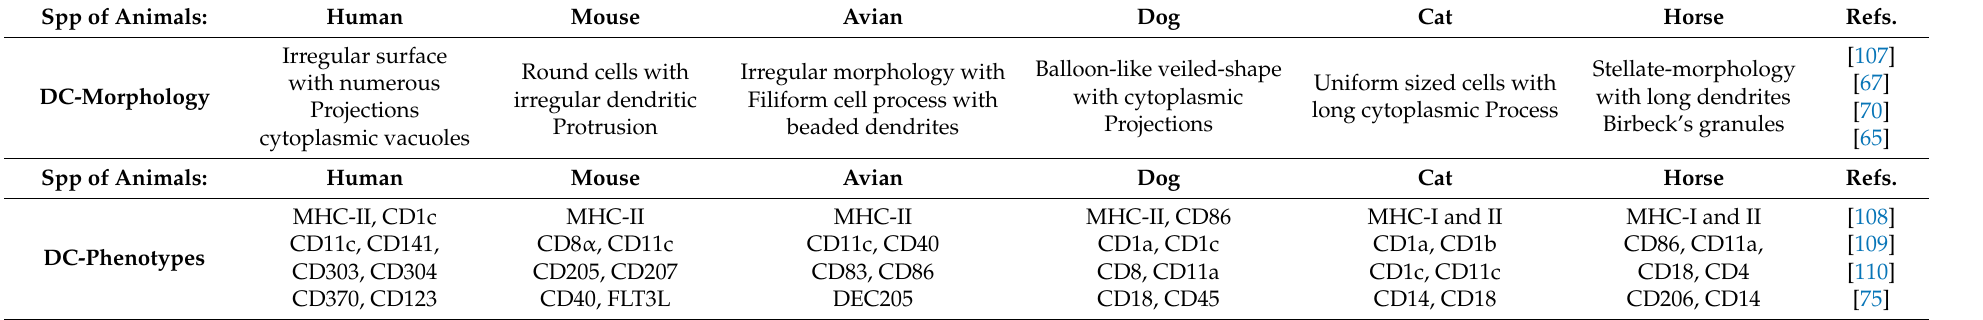
Table 2. The Dendritic cell (DC) morphology and phenotype in different species of animal.